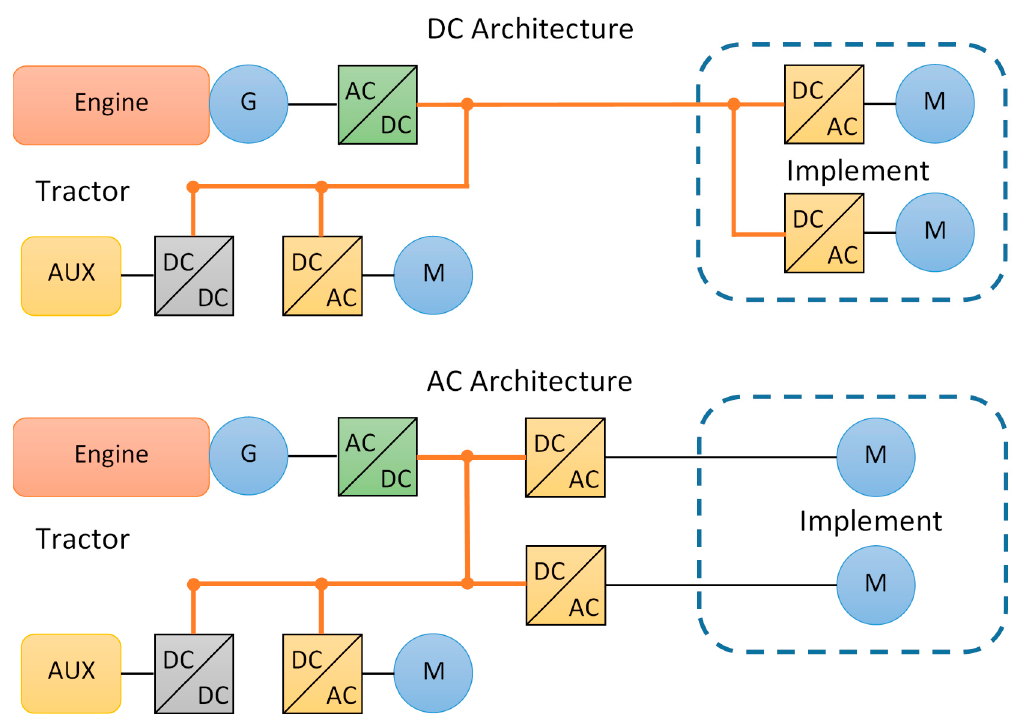
Figure 5. Examples of electric system architectures for agricultural tractors: G = Generator, M = Motor, AUX = Auxiliary devices (Data from [60]).